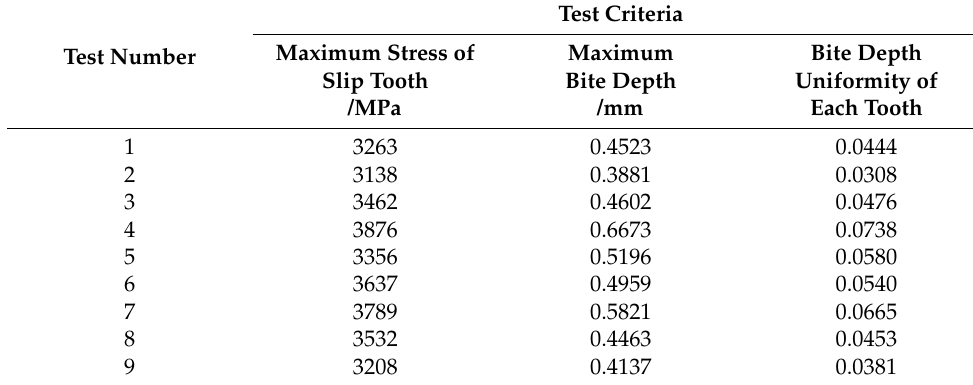
Table 4. Orthogonal test result.